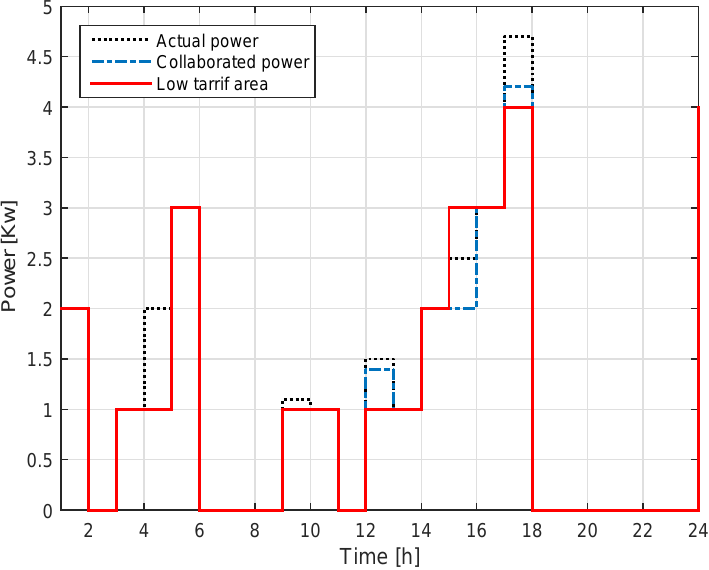
Figure 5. Collaborated power after discharge action of